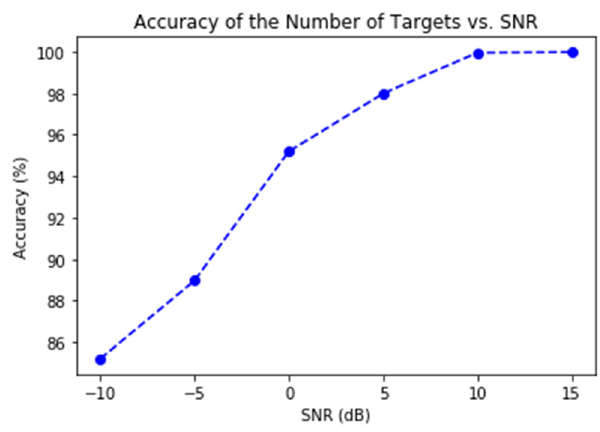
Figure 7. The accuracy of determining the number of targets vs. SNR.